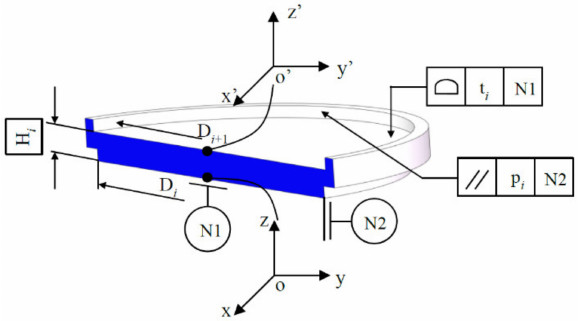
Figure 4. The geometric model with variation